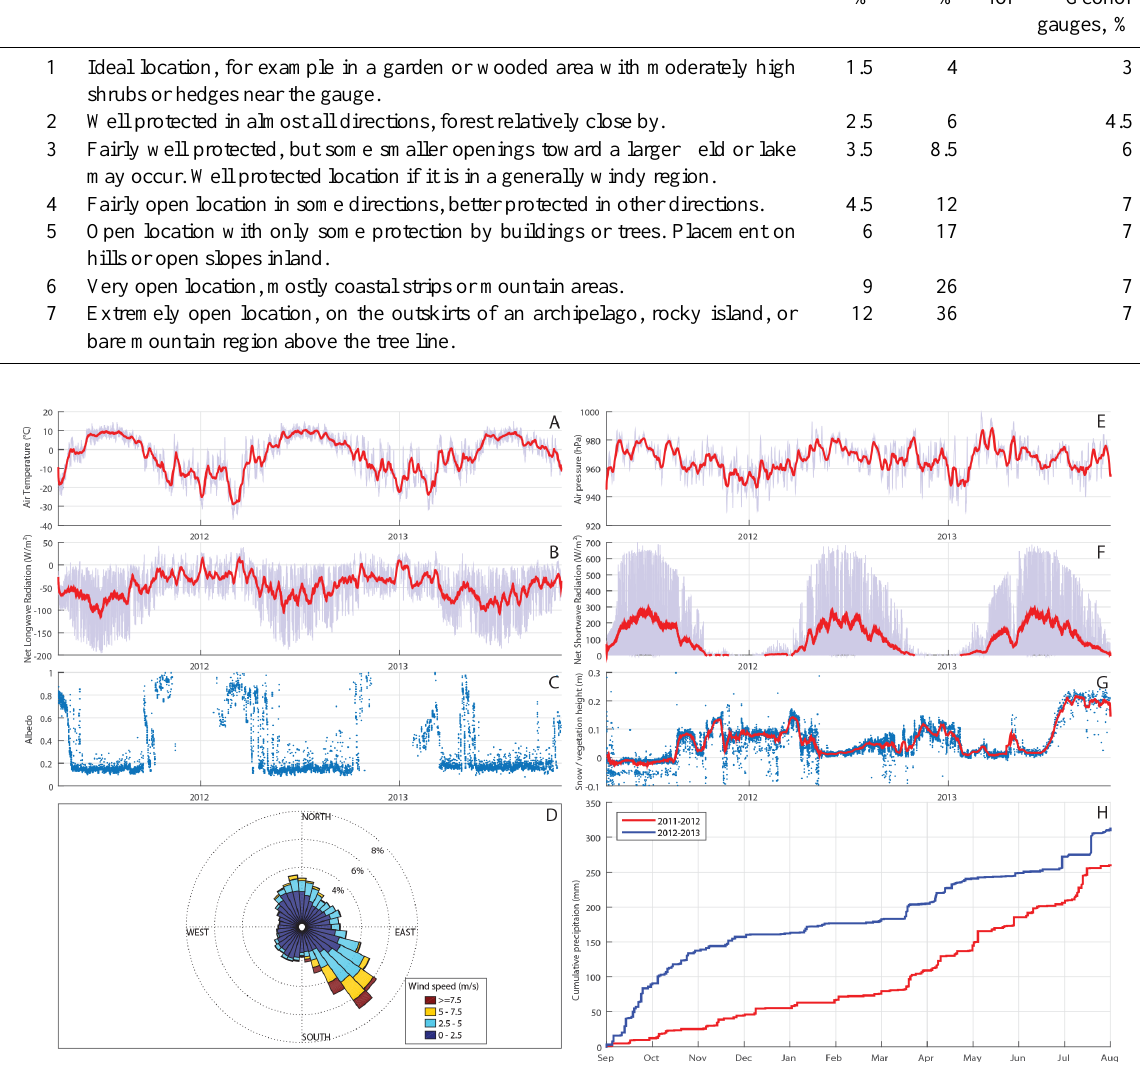
Figure 5. Climate data time series from April 2011 until December 2013. (a) Temperature ( ◦ C), (b) net longwave radiation (Wm − 2 ), (c) albedo (–), (d) wind speed (ms − 1 ) and direction ( ◦ N), (e) air pressure (hPa), (f) net shortwave radiation (Wm − 2 ), (g) snow depth/vegetation height (m), and (h) cumulative precipitation